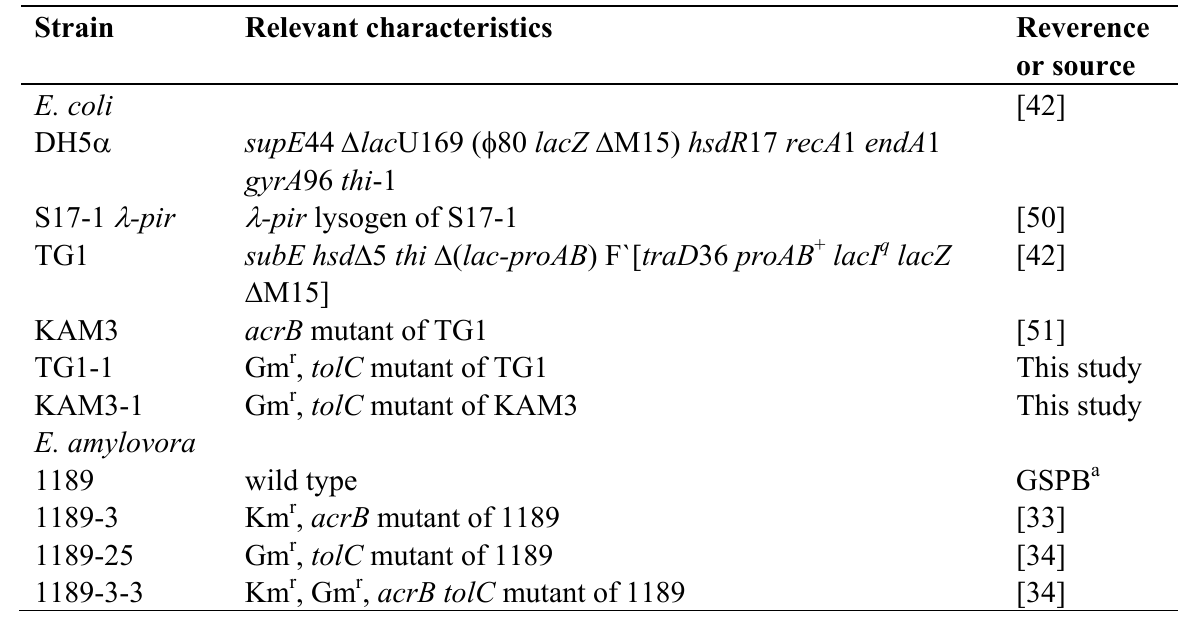
Table 5. E. coli and E. amylovora strains used in this